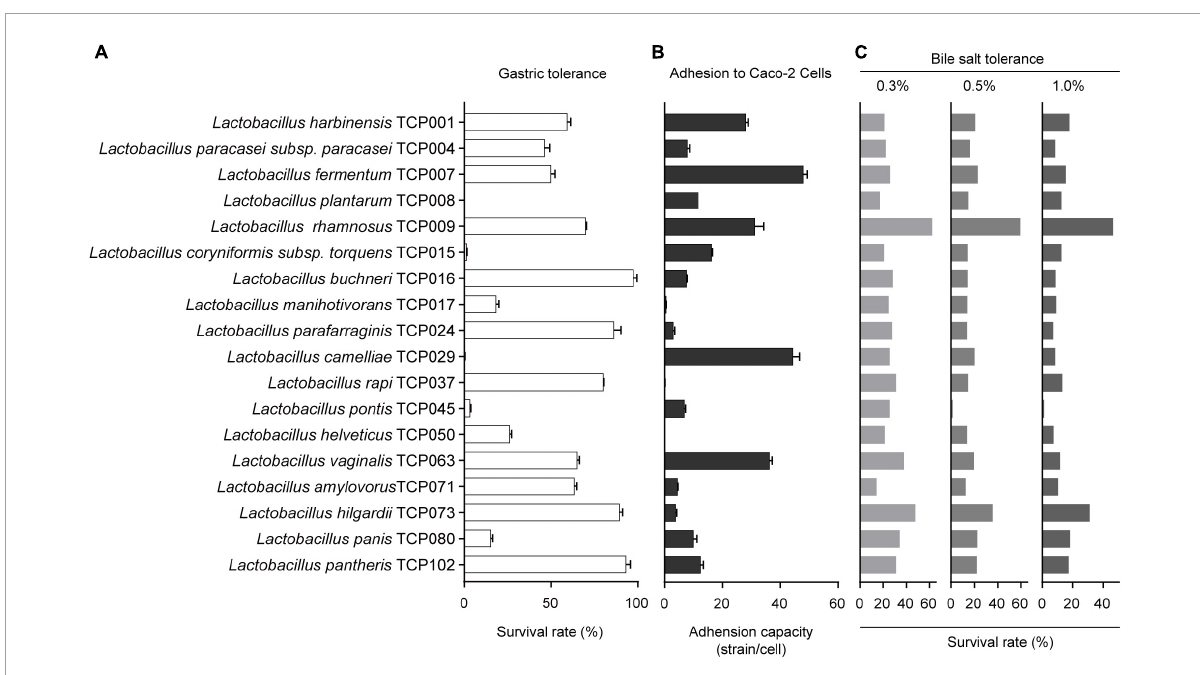
FIGURE1 The evaluation of probiotic properties of lactic acid bacteria. (A) The results of the tolerance of 18 lactic acid bacteria strains to artificial gastric juice. (B) The adhesion results of 18 lactic acid bacteria strains to Caco-2 cells. (C) The results of bile salts tolerance of 18 lactic acid bacteria